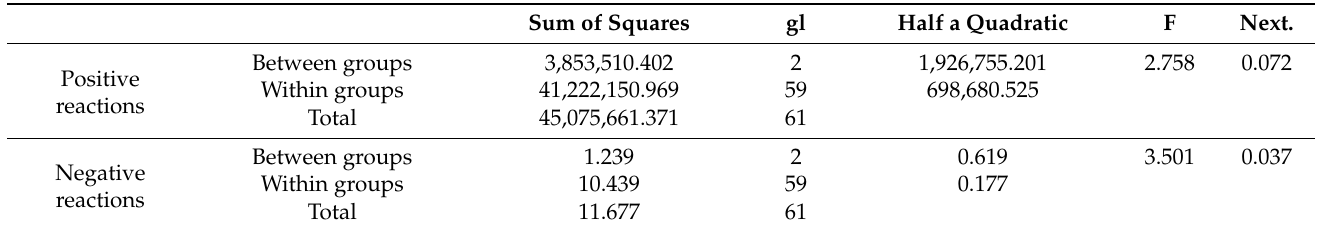
Table 8. ANOVA statistics of positive and negative reactions according to the brand content. Sum of Squares gl Half a Quadratic F